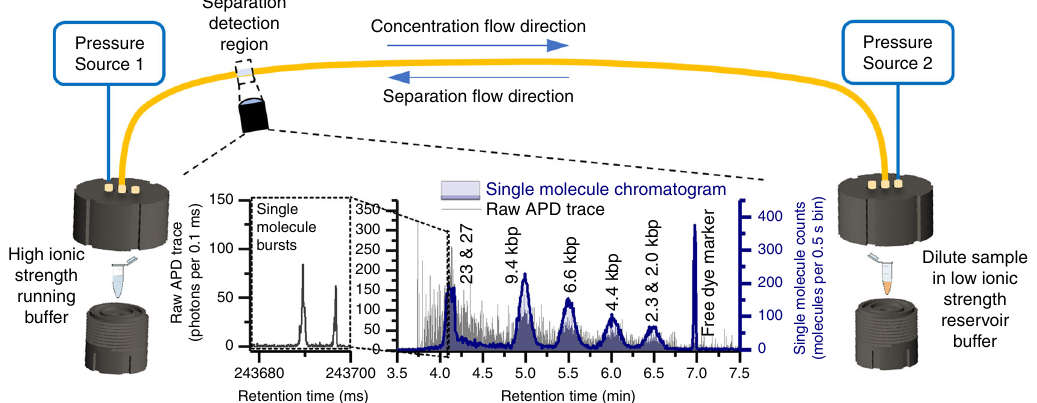
Fig. 3 Coupled preconcentration, free solution hydrodynamic separation, and single-molecule detection platform. Each end of a long microcapillary is placed into its own individually controled pressure chamber to enable precise control over the direction and speed of fl uid fl ow. Concentration occurs by applying positive pressure to the running buffer pressure chamber with Pressure Source 1, and sample injection and separation occur with positive pressure applied to the opposite end of the capillary with Pressure Source 2. The CICS observation volume is aligned with the detection region to enable detection of single DNA molecules (grey, background), which are counted to generate a single-molecule chromatogram (navy, shaded foreground). This example chromatogram was generated after performing 100× MRT preconcentration and free solution separation of Hin dIII digested λ